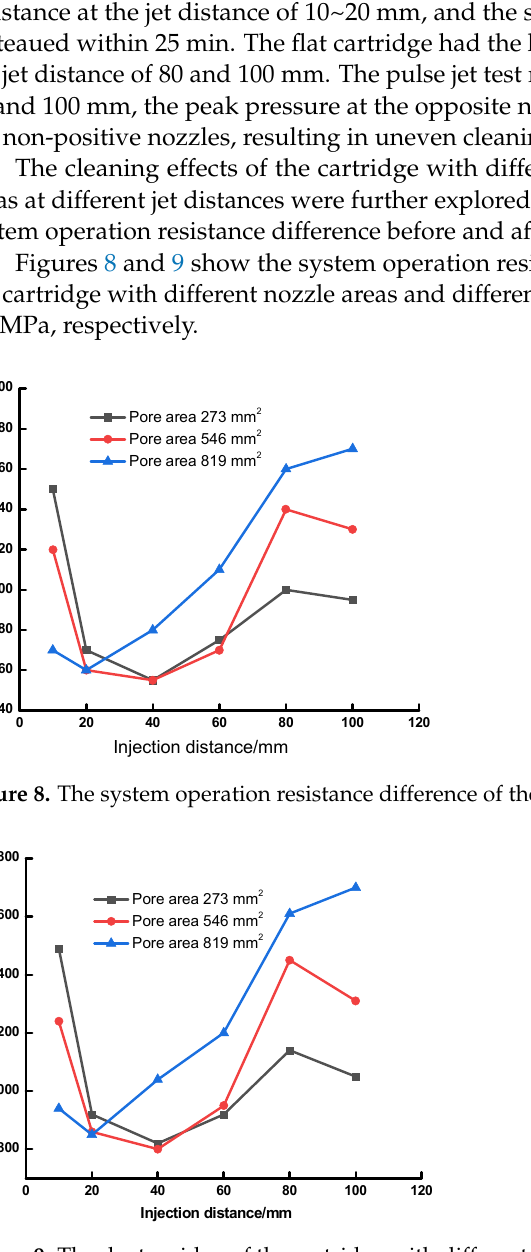
Figure 9. The dust residue of the cartridge with different nozzle areas and different jet distances at the pulse pressure of 0.3 MPa.